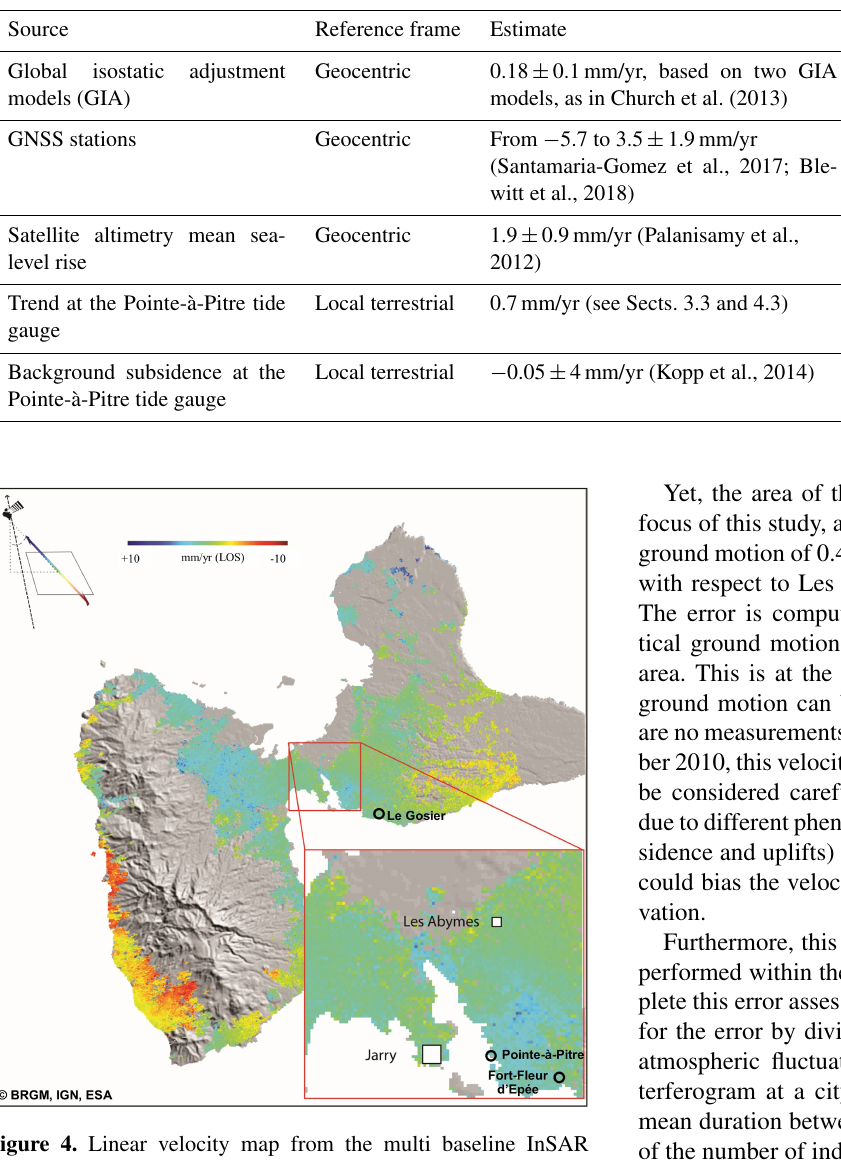
Table 3. Pointwise vertical ground motions estimates from different sources.